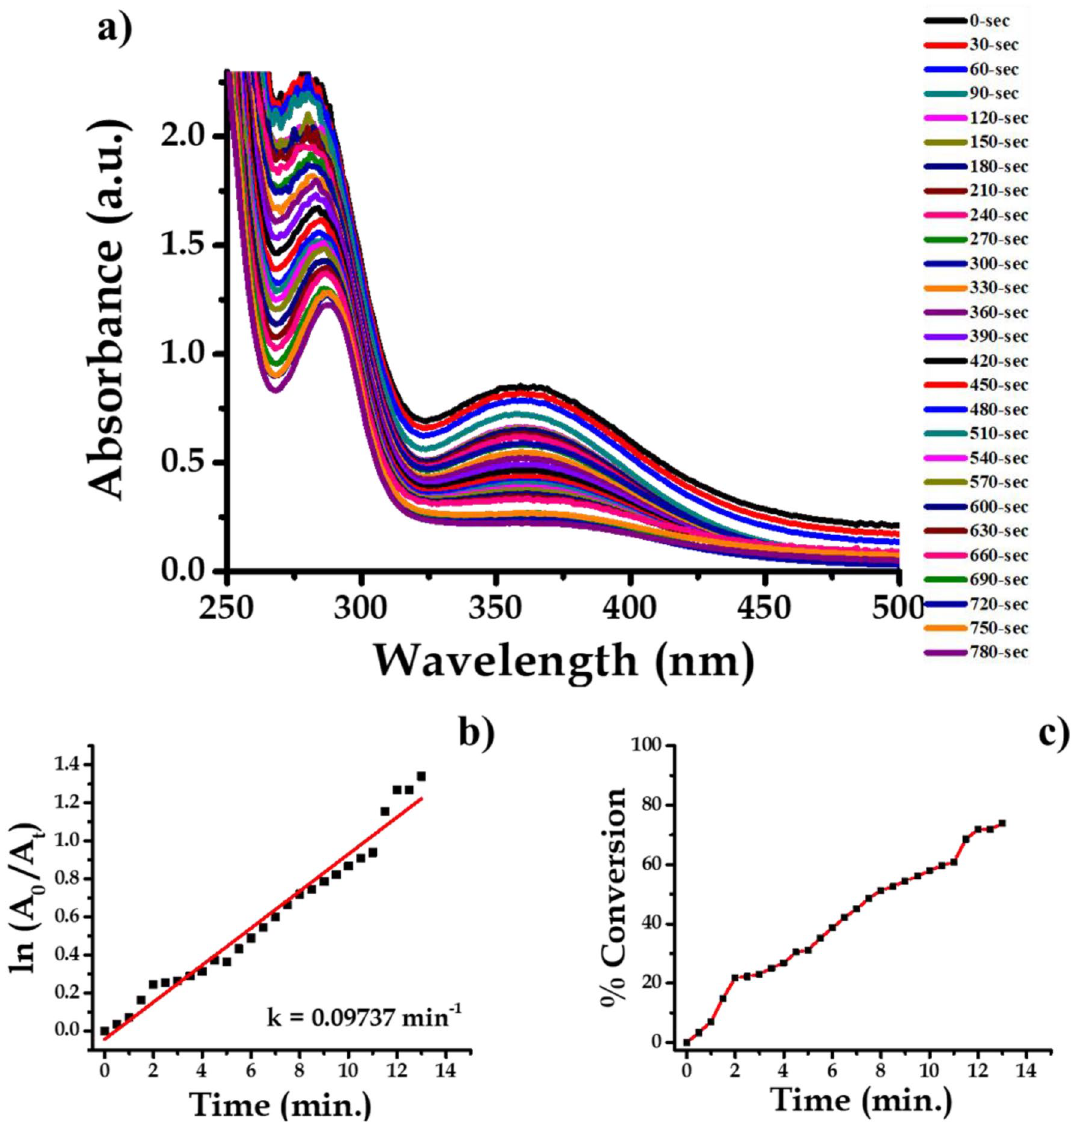
Figure 16. UV–Vis absorption spectra of ( a ) 3-nitroaniline, ( b ) kinetics of catalytic reduction and ( c ) percentage conversion of